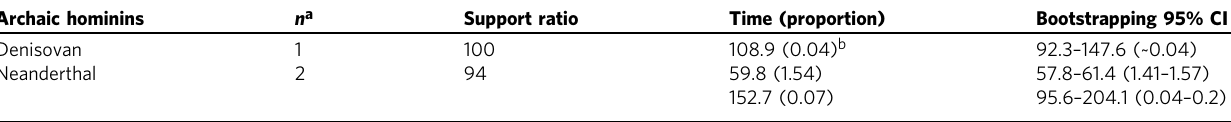
Table 3 Introgression history inference for Ust ’